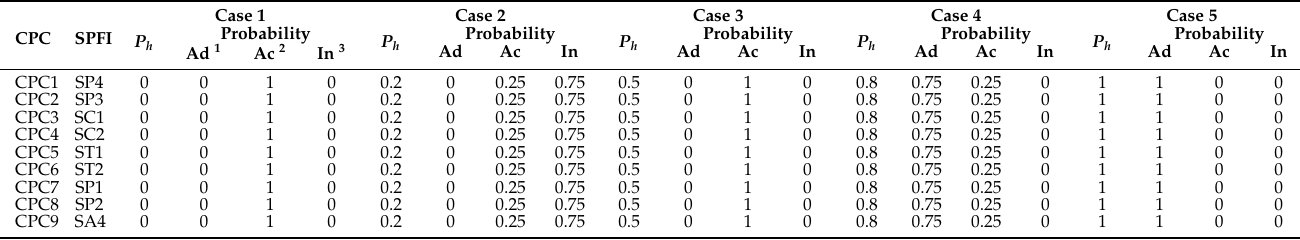
Table 11. The probabilities of the common performance condition indicators (CPCs) for five cases.